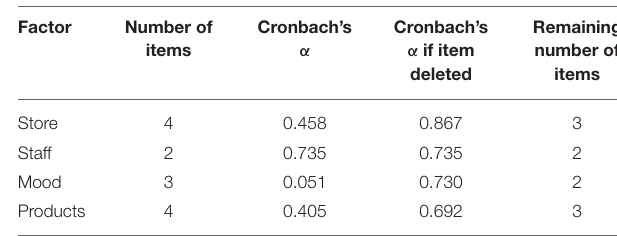
TABLE 1 | Cronbach’s α before and after removing items from Store, Staff, Mood, and